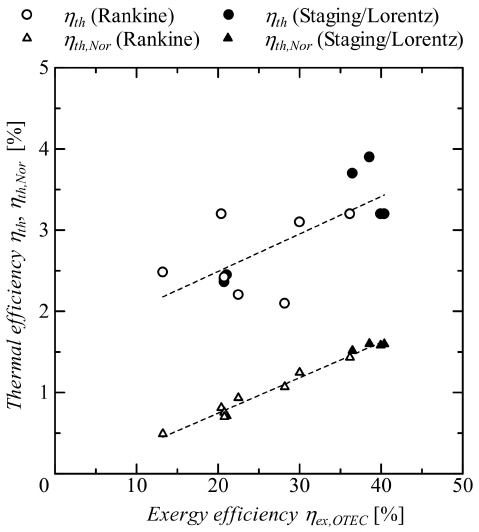
Figure 8. Relation between exergy efficiency and thermal efficiency. The open and close circles show the conventional thermal efficiency, η th , and the open and close triangles show the normalized thermal efficiency, η th,Nor